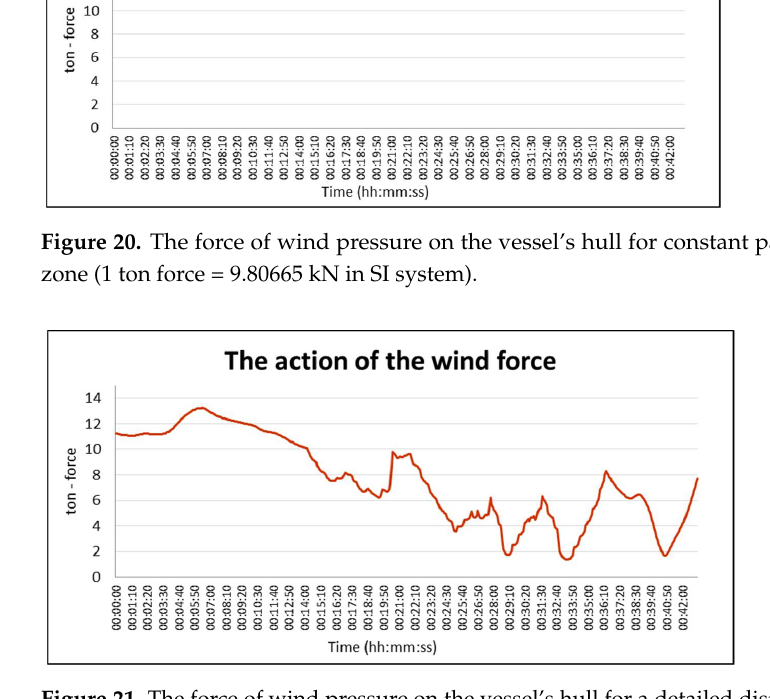
Figure 21. The force of wind pressure on the vessel’s hull for a detailed distribution of the wind field (1 ton force = 9.80665 kN in SI system). (1 ton force = 9.80665 kN in SI